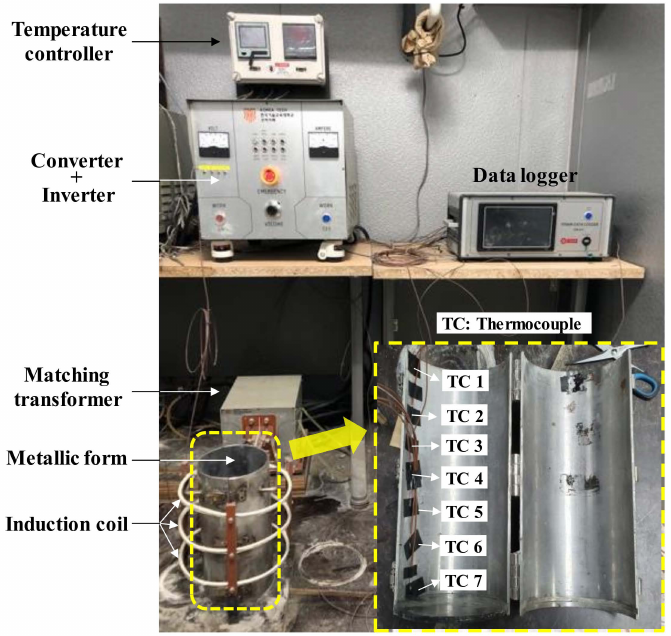
Figure 6. Experiment set-up: induction heating system and inside the metallic form with